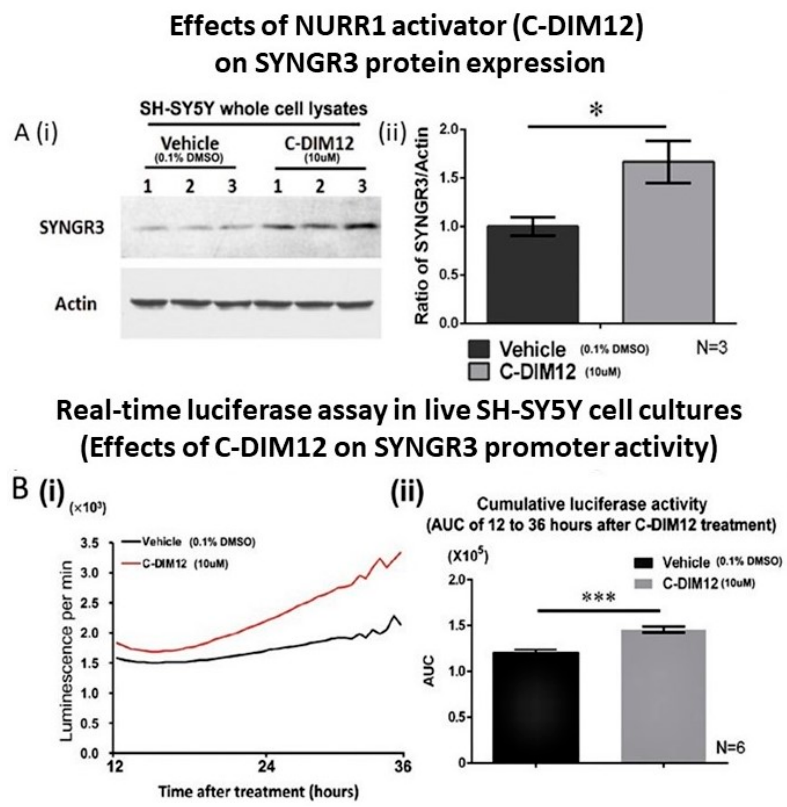
Figure 7. Effects of Nurr1 activator C-DIM12 on protein expression in SH-SY5Y cells and the effect of activator activity assayed in real time. ( A ) (i) total cell lysates from vehicle-treated and C-DIM12 treated SH-SY5Y cells were detected by anti-SYNGR3 and anti-Actin antibodies. The Western blots showed bands at 25 kDa corresponding to SYNGR3 and bands at 43 kDa corresponding to actin. SYNGR3 protein expression increased in SH-SY5Y cells treated with C-DIM12 compared with that in cells treated with vehicle. (ii) quantitative measurement of the SYNGR3 expression levels in C-DIM12 and vehicle-treated cells. ( B ) (i) schematic diagram of the luciferase reporter plasmids cloned with the 2029-bp 5 ′ -flanking region of pGL3-hSYNGR3 − 1870/ATG containing three NBRE-like elements. SH-SY5Y cells were transiently transfected with the pGL3-hSYNGR3 − 1870/ATG construct containing three NBRE-like elements. Real-time luciferase activity was measured from 12 h to 36 h following treatment with vehicle and C-DIM12 (10 μ M) in SH-SY5Y cells. (ii) Cumulative luciferase activity was calculated from the area under the curve (AUC) of the real-time luciferase activity of pGL3-hSYNGR3 − 1870/ATG in SH-SY5Y cells treated with vehicle and C-DIM12. Values are mean ± SEM of six independent experiments. *** indicates significance at p < 0.01 as compared to vehicle-treated controls. * indicates significance at p < 0.05 compared with the level in vehicle-treated con- trols. The bars indicate mean ± SEM of the three independent experiments.